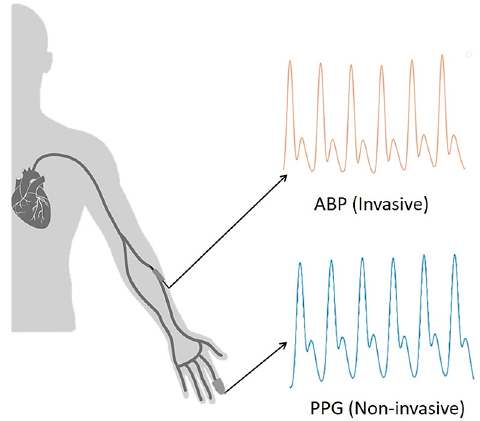
Figure 1. Conventional photoplethysmogram (PPG) and arterial blood pressure (ABP) measure- ment